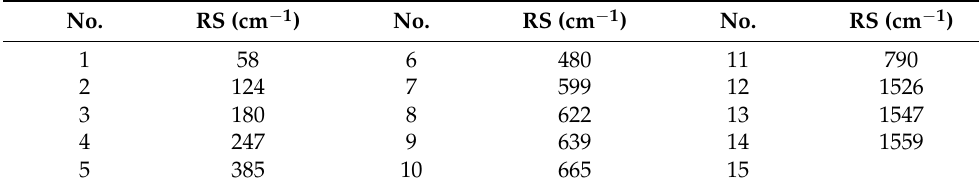
Figure 4. The distribution of the difference between the spectral peak and valleys in the amplified signal spectrum shown in Figure 2. The experimental condition of the pre-compensation and stretching of the pump pulse are the same as in Figure 1. The marks represent the difference of the peak–peak, valley–valley, and peak–valley in Figure 2 and the differences in wave number are given by the ordinate. The positions of the marks in the abscissa are arbitrarily set for the plotting to be easily observed with moderate density of the dots without any specific meaning. Table 1. Raman frequency shift (RS) in BBO crystal from Ref. (Chin. Phys. Lett. 19 (2002)